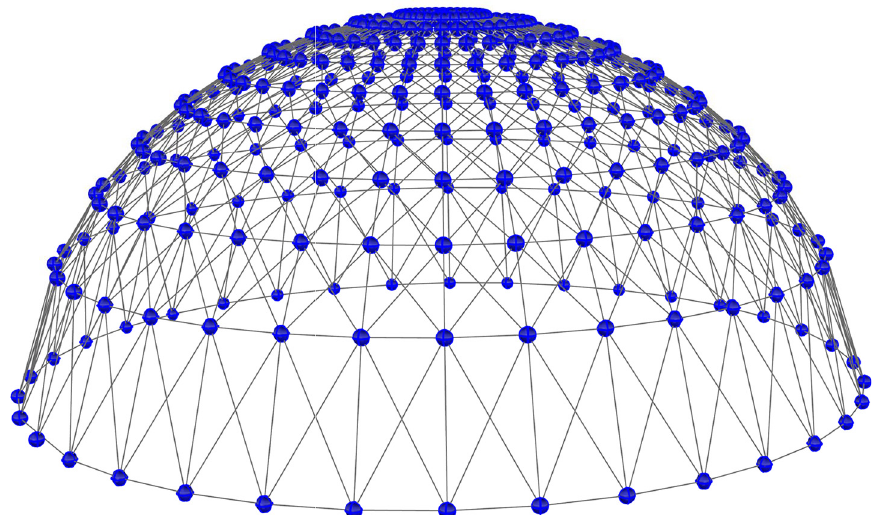
Figure 2. Initial connection